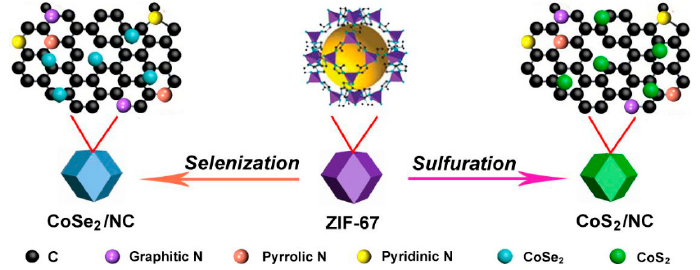
Figure 8. Illustration of synthesis and structure for preparing CoSe2/NC and CoS2/NC. Reproduced with permission from [166].